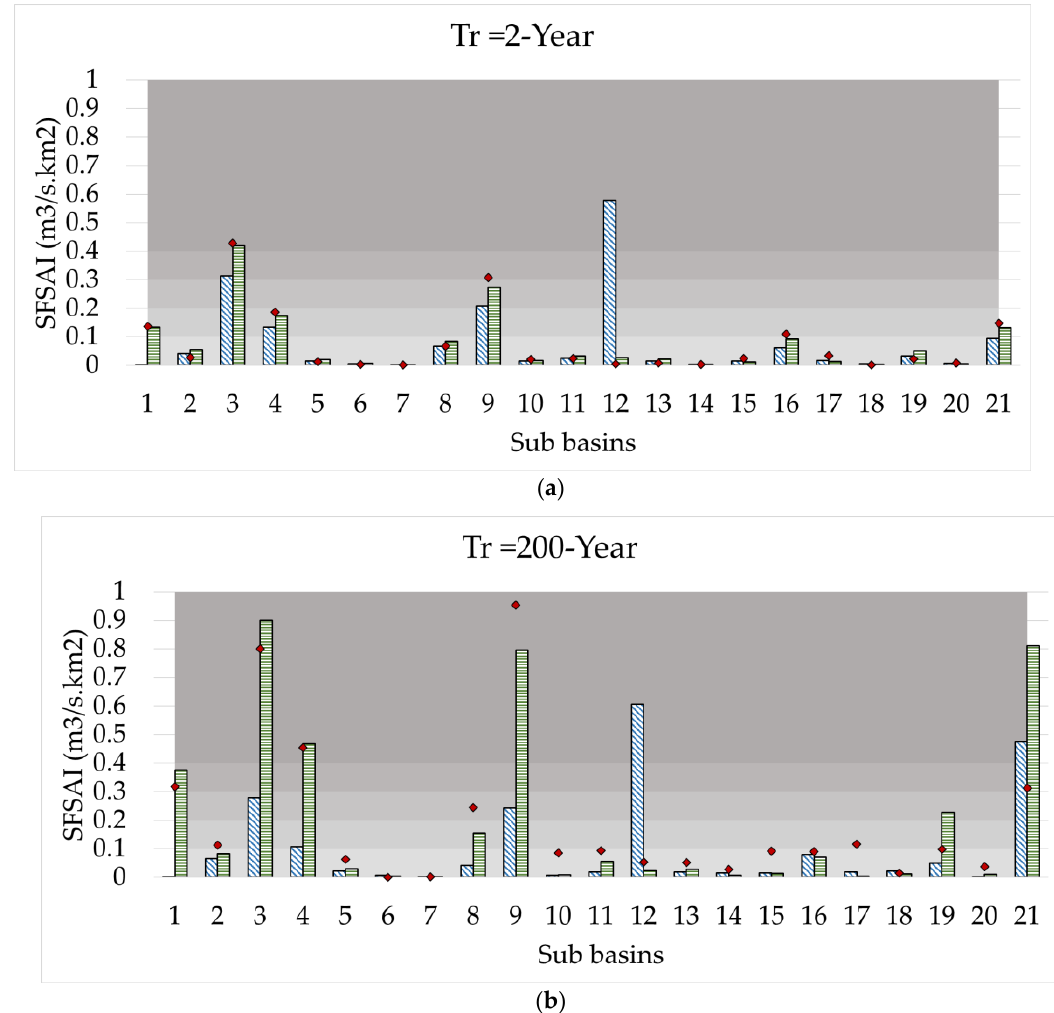
Figure 12. Comparison of SFSAI in each subbasin for the present and near future periods, RCP 2.6 and RCP 8.5, for 2 ( a ) and 200 ( b ) year return periods.